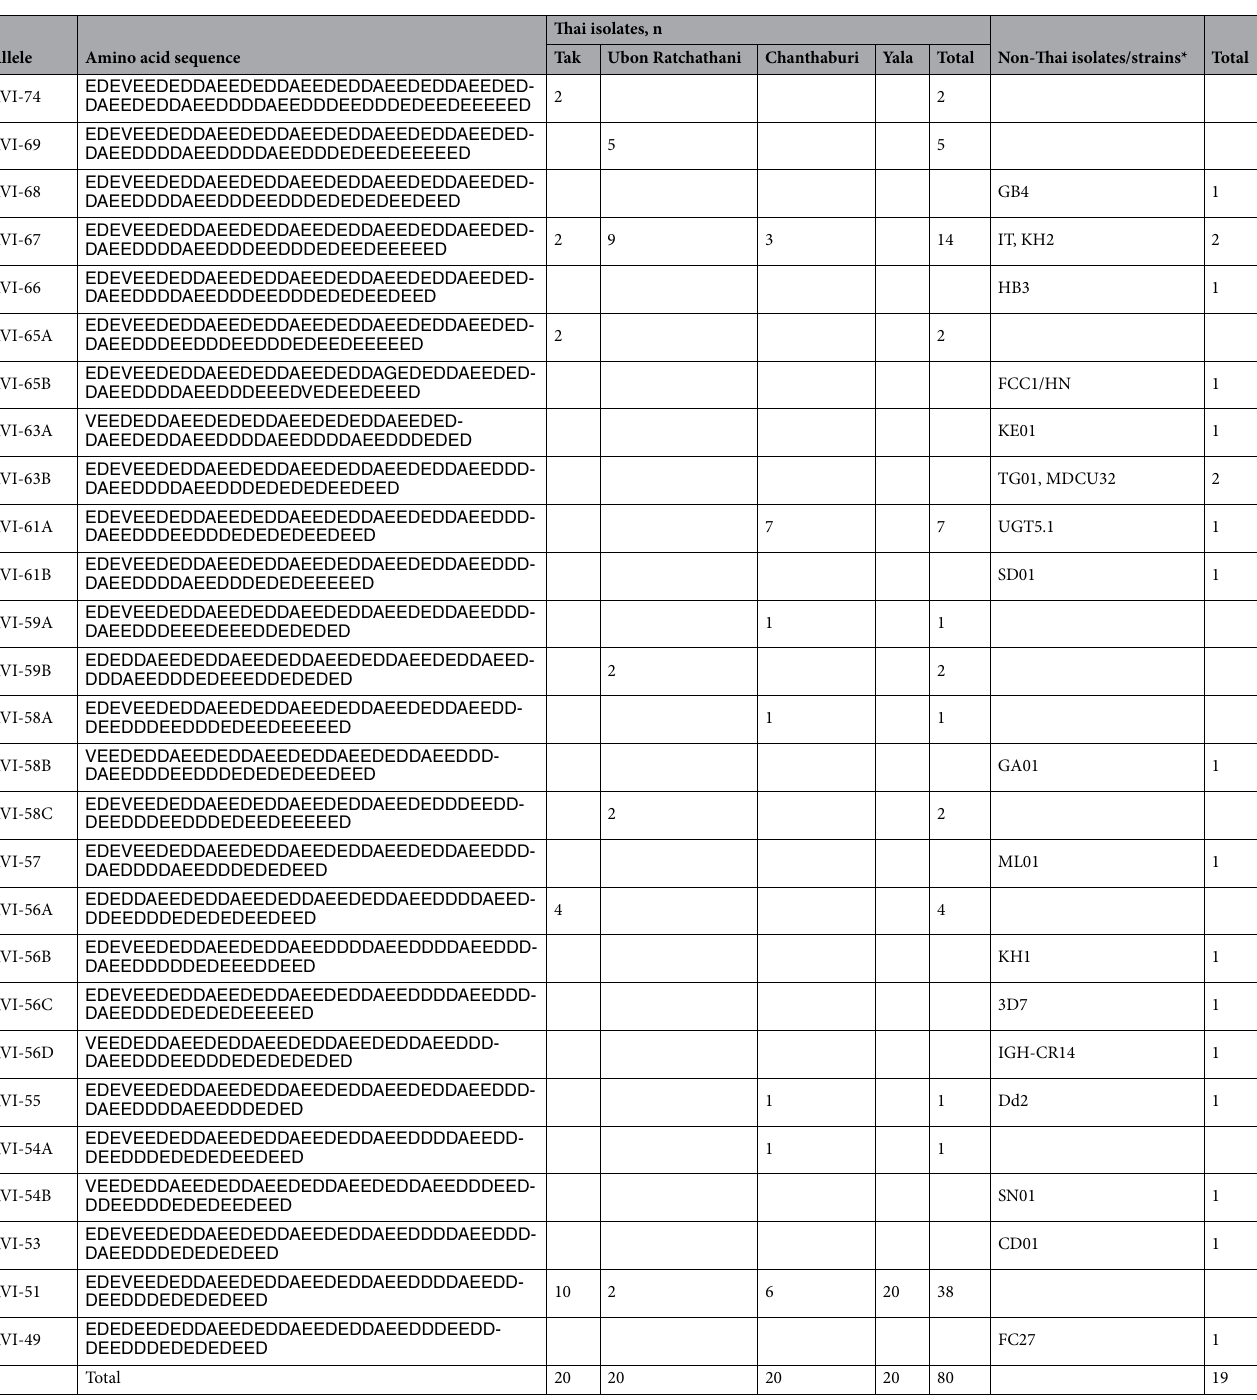
Table 5. Diversity and distribution of repeat alleles in block 11 (repeat domain VI) of PfGARP. MDCU32 is from a Guinean patient. *GenBank accession numbers are listed in “Materials and